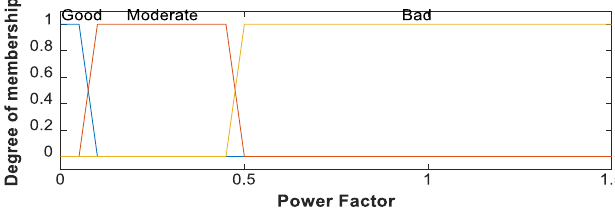
Figure 7. Membership functions for power factor.